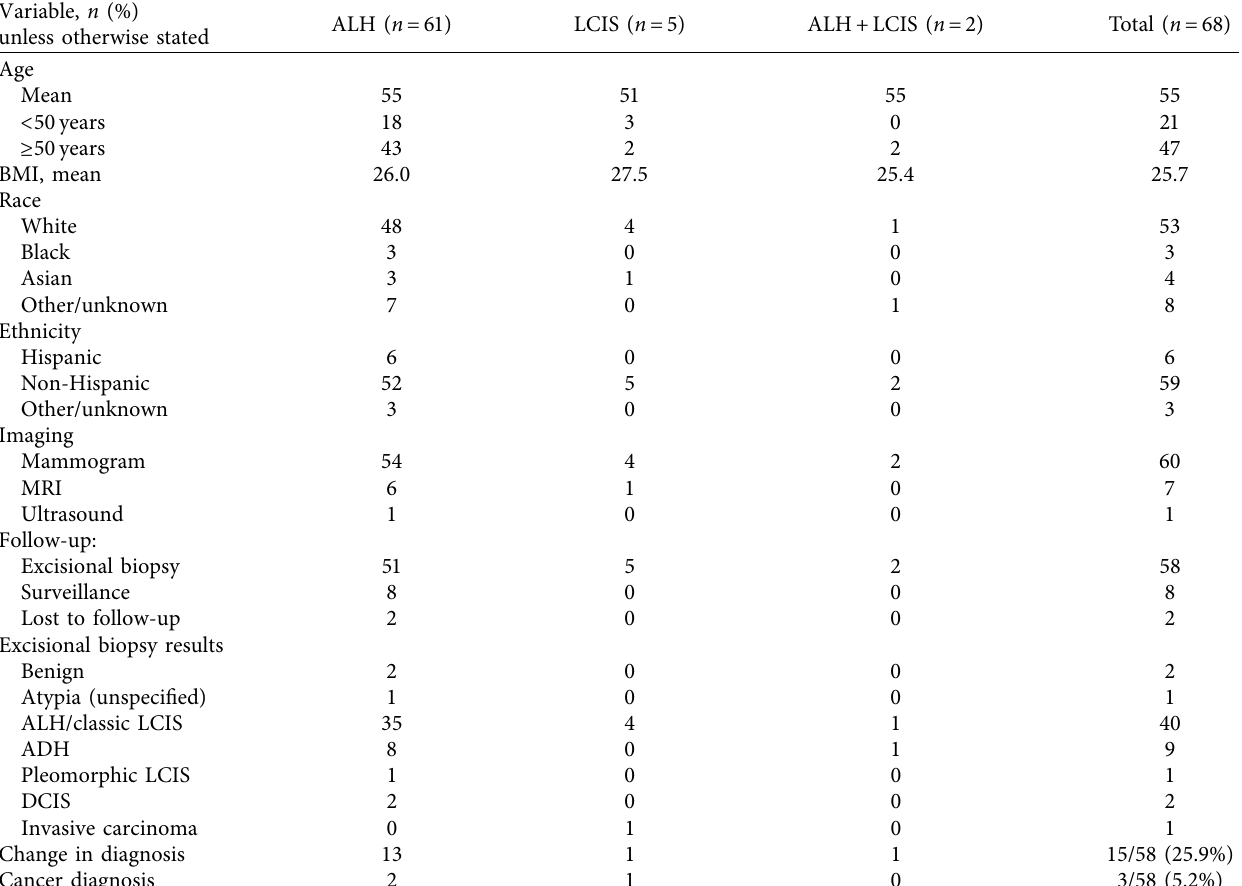
Table 1: Patient characteristics and